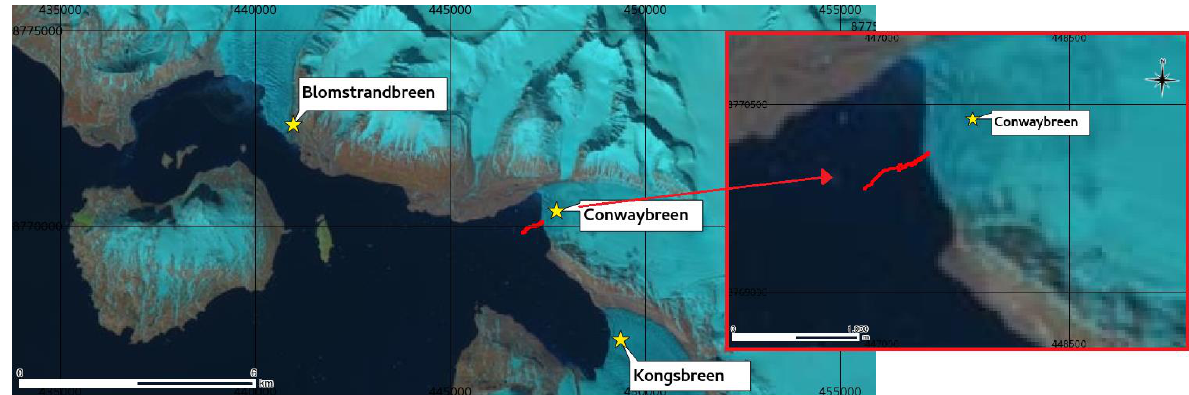
Figure 6. Sentinel-2 satellite image showing the position of three tidewater glaciers in the Kongsfjorden. In the red box on the right, the position of the Conwaybreen glacier front is shown together with the transect made with PROTEUS (red track).